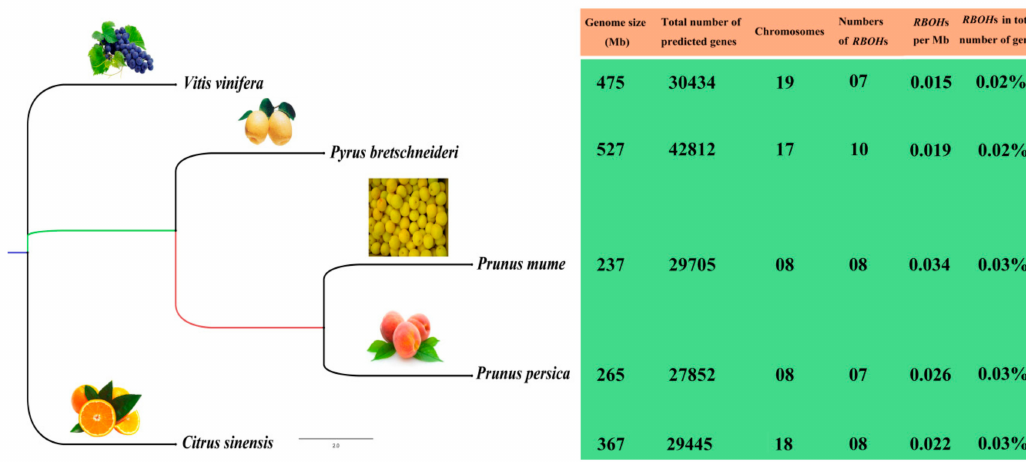
Figure 1. A summary of the evolutionary relationships, genome size, and RBOH distribution of the five fruit-producing